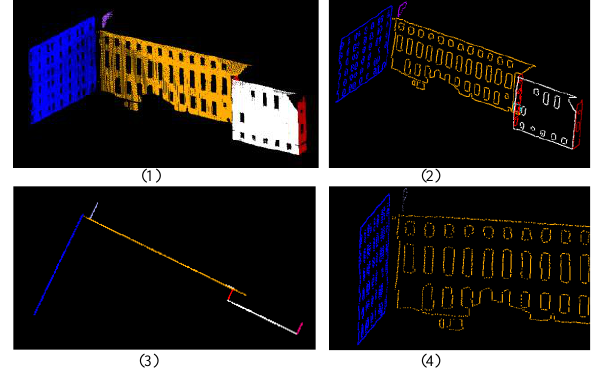
Figure 6. Examples of the components of a building and their boundaries obtained from a point cloud